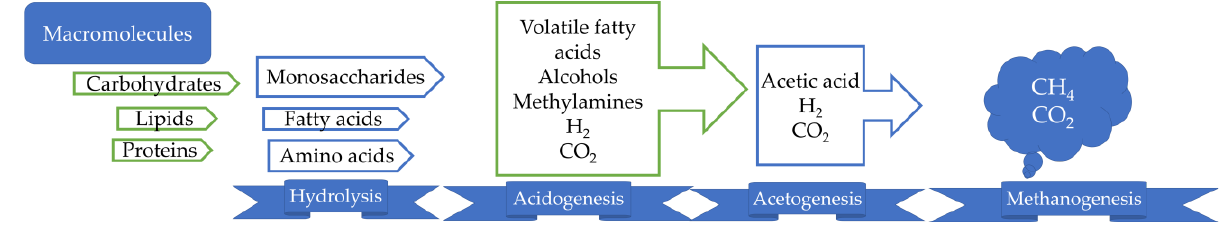
Figure 2. The anaerobic digestion